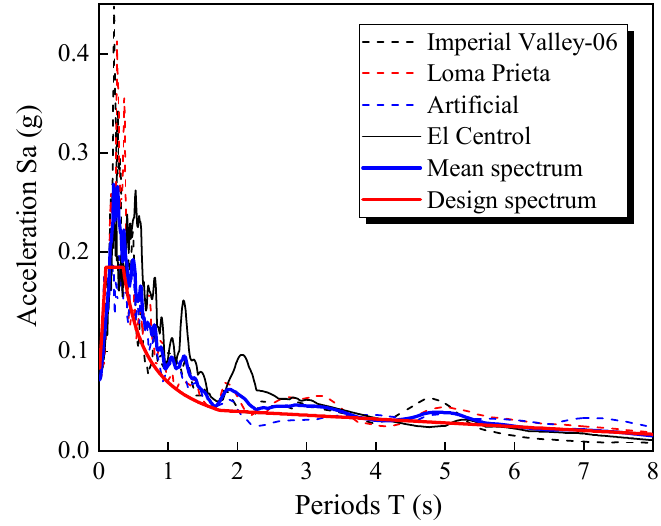
Figure 14. Acceleration response spectra for the ground motions.